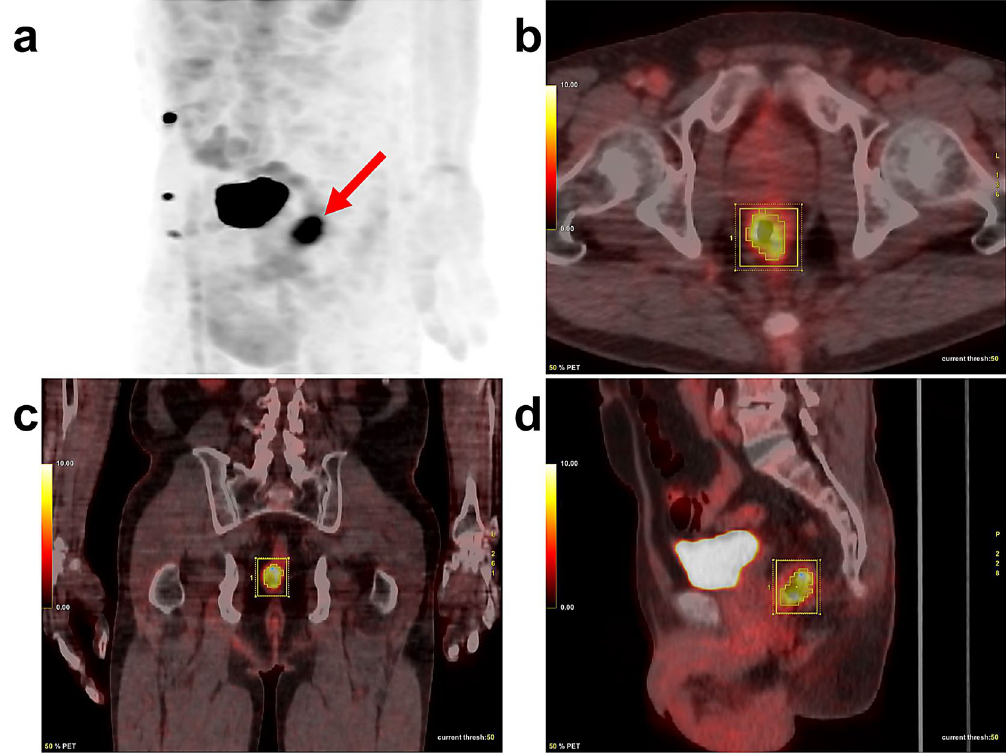
Figure 4. Representative case for the measurement of the maximum standardized uptake value (SUVmax), metabolic tumour volume (MTV), and total lesion glycolysis (TLG) in a 64-year-old male patient with rectal cancer. The maximum intensity projection image shows well-demarcated primary rectal cancer lesion ( a ) (arrow). We drew a volume of interest to sufficiently surround the primary rectal cancer lesion on transaxial ( b ), coronal ( c ), and sagittal ( d ) images. Then the software automatically calculated the SUVmax (10.40), MTV (7.97 cm 3 ), and TLG (56.3